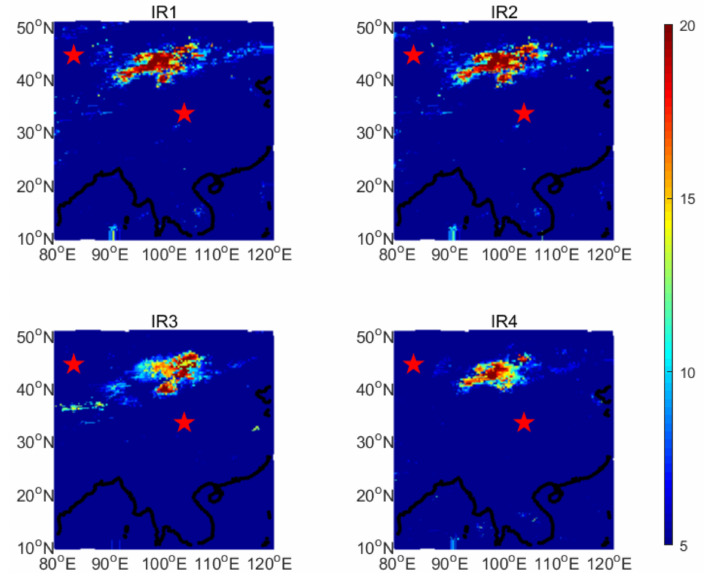
Figure 10. Power spectrum images on 20 July 2017.